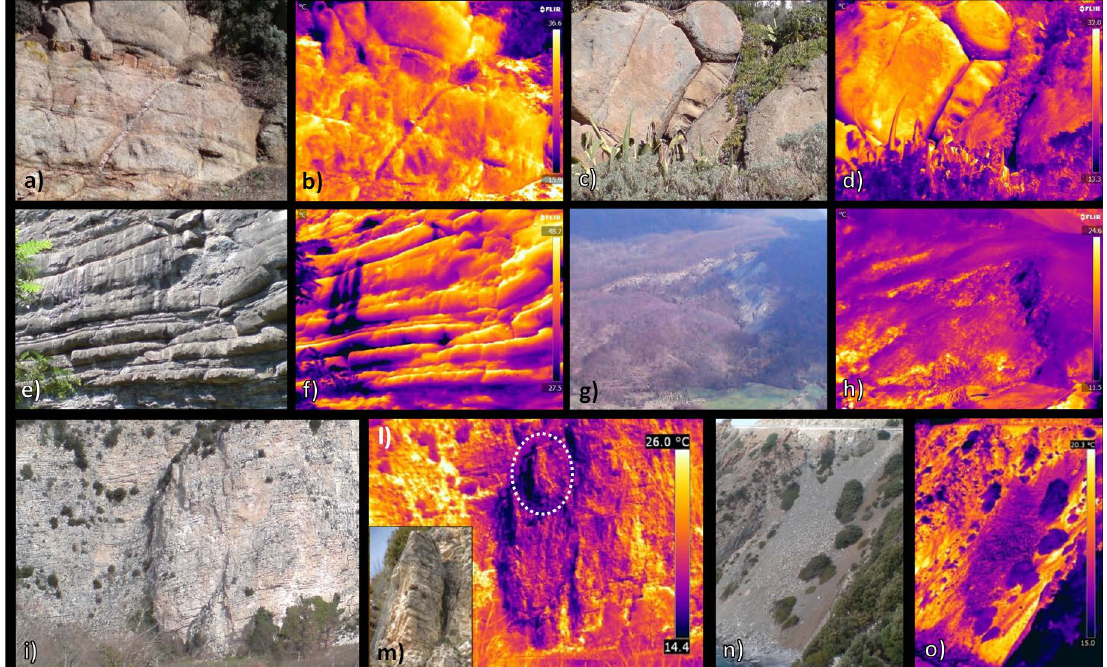
Figure 3. Examples of thermograms displaying thermal anomalies connected to slope instability phenomena in Italy. Dykelets and open fractures at Giglio Island, Tuscany ( a – d ); water seepage in sandstone layers (Fiesole, Tuscany) ( e , f ); aerial imaging of large landslide (San Benedetto Val di Sambro, Emilia Romagna) ( g , h ); unstable rock wall sector in (Val Nerina, Umbria) ( i – m ); debris apron along coastal cliff (Elba Island, Tuscany) ( n , o